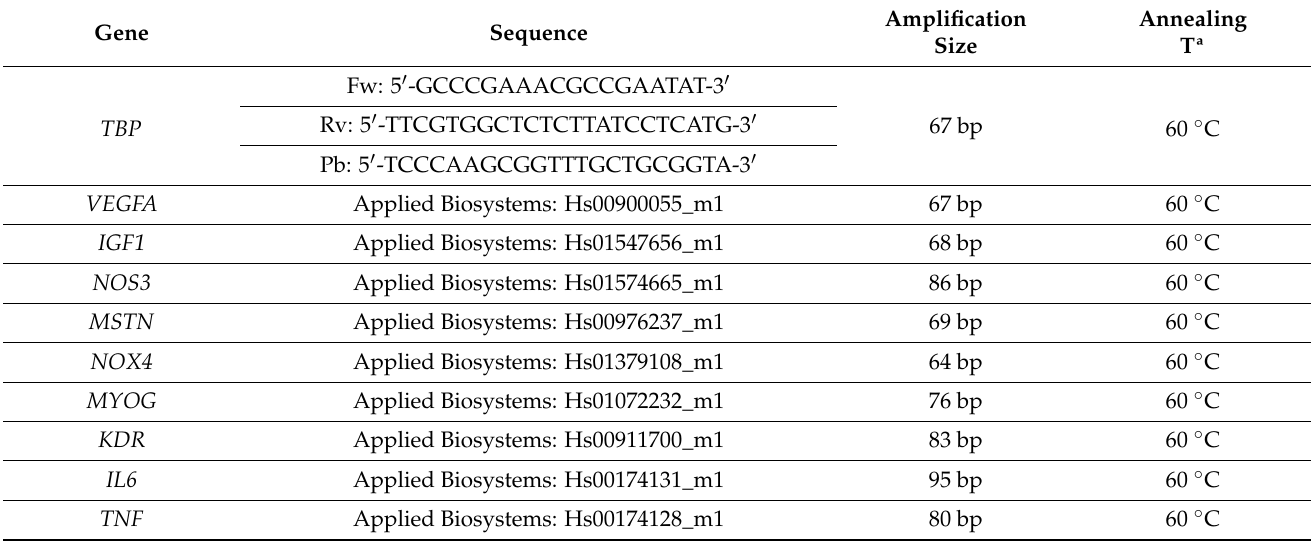
Table 1. Real-time PCR (RT-qPCR). Primer sets, TaqMan assays and conditions used for